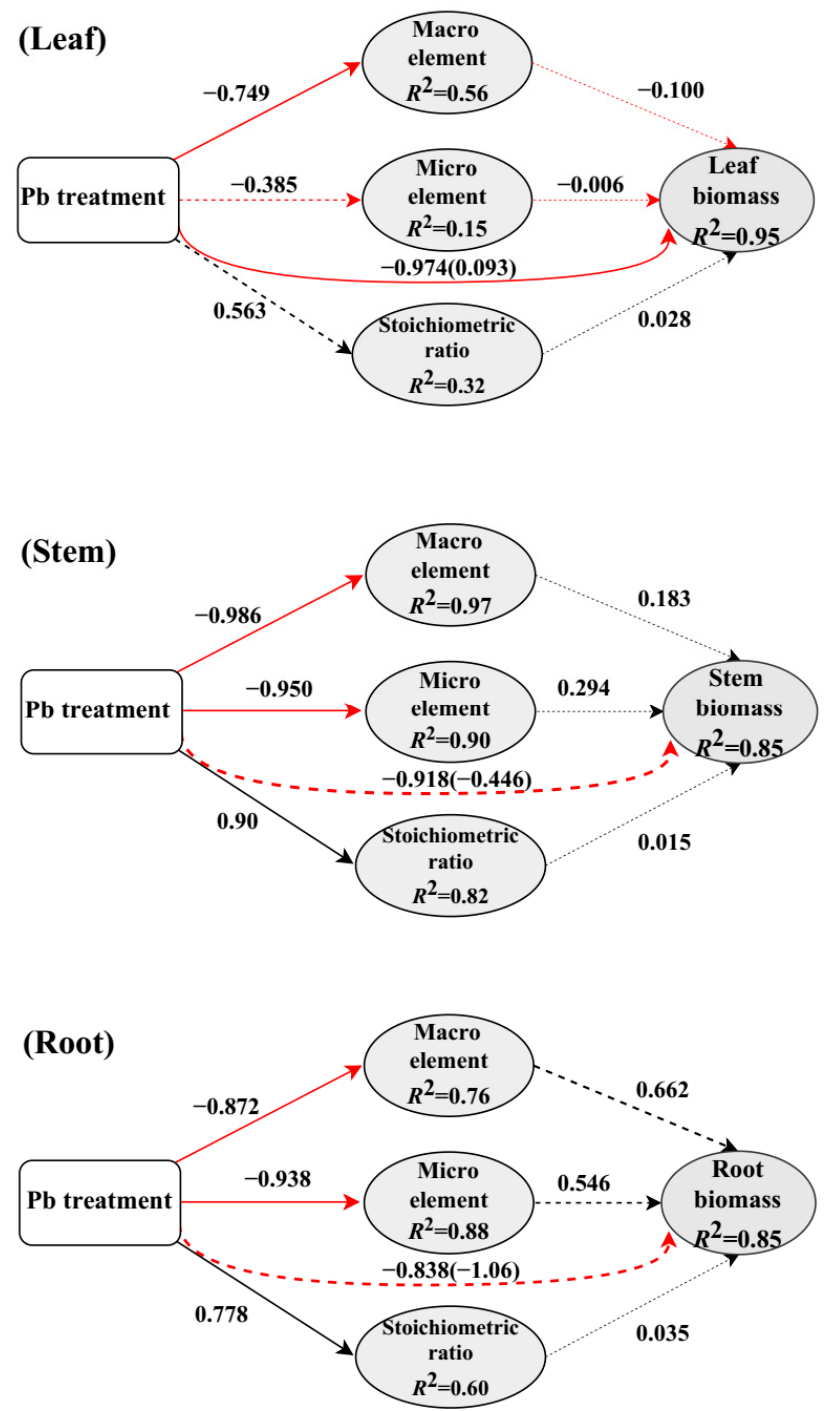
Figure 6. Partial least-squares path modeling (PLS − PM) of Pb effects on the plant elements, plant stoichiometry and biomass production in leaf, stem, and root of R. chinensis . Measured variables (Pb treatment) are indicated by rounded rectangles and potential variables (macro element, micro element, stoichiometric ratio, biomass) are indicated by ovals. Black and red arrows indicate positive and negative effects, respectively, and the width of the line indicates the intensity of the direct effect. The numbers near the solid and dashed arrows indicate significant and nonsignificant normalized pathways, respectively, and the numbers in parentheses indicate the path coefficients of indirect effects. Goodness of fit (GoF) statistical superiority was used to evaluate the model; the GoF for leaf, stem, and root were 0.63, 0.80, and 0.77, respectively.